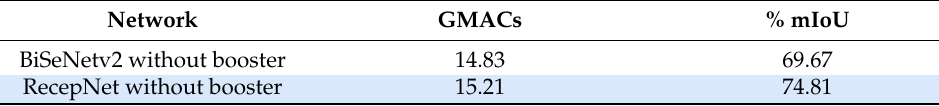
Table 9. Comparison of two networks without booster.